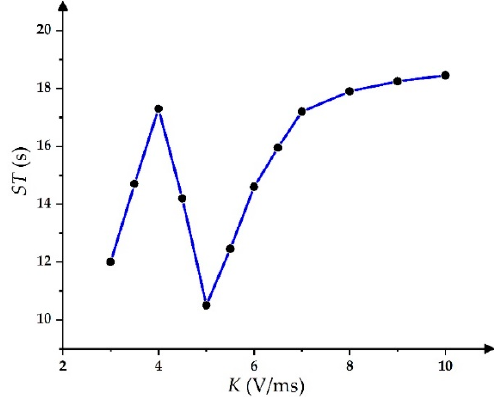
Figure 11. The relationship between ST and the slope of the driving waveform.